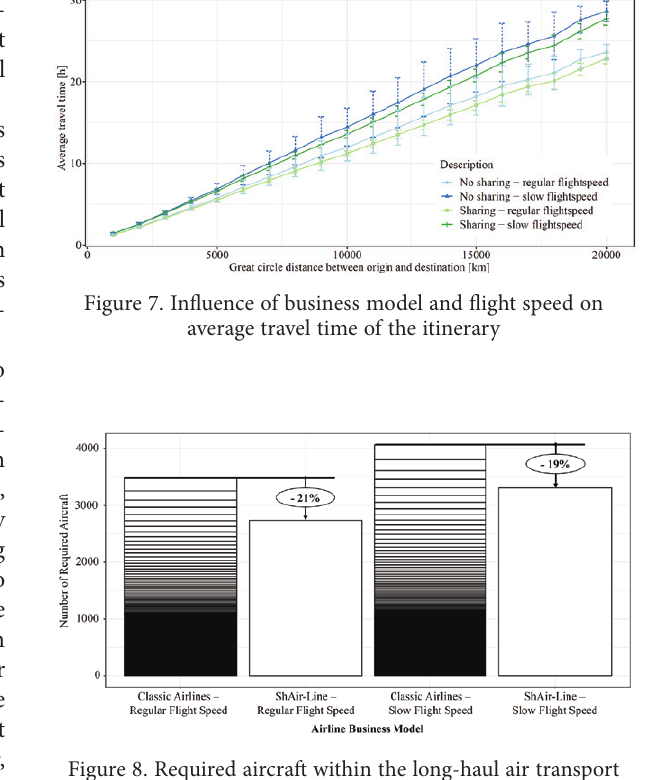
Figure 8. Required aircraft within the long-haul air transport network depending on the airline business model and aircraft fl ight